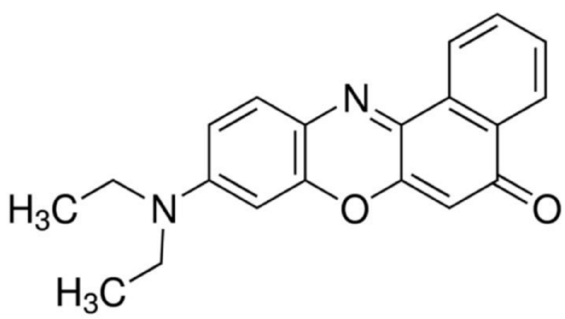
Figure 1. Chemical structures of PMMA-NR.